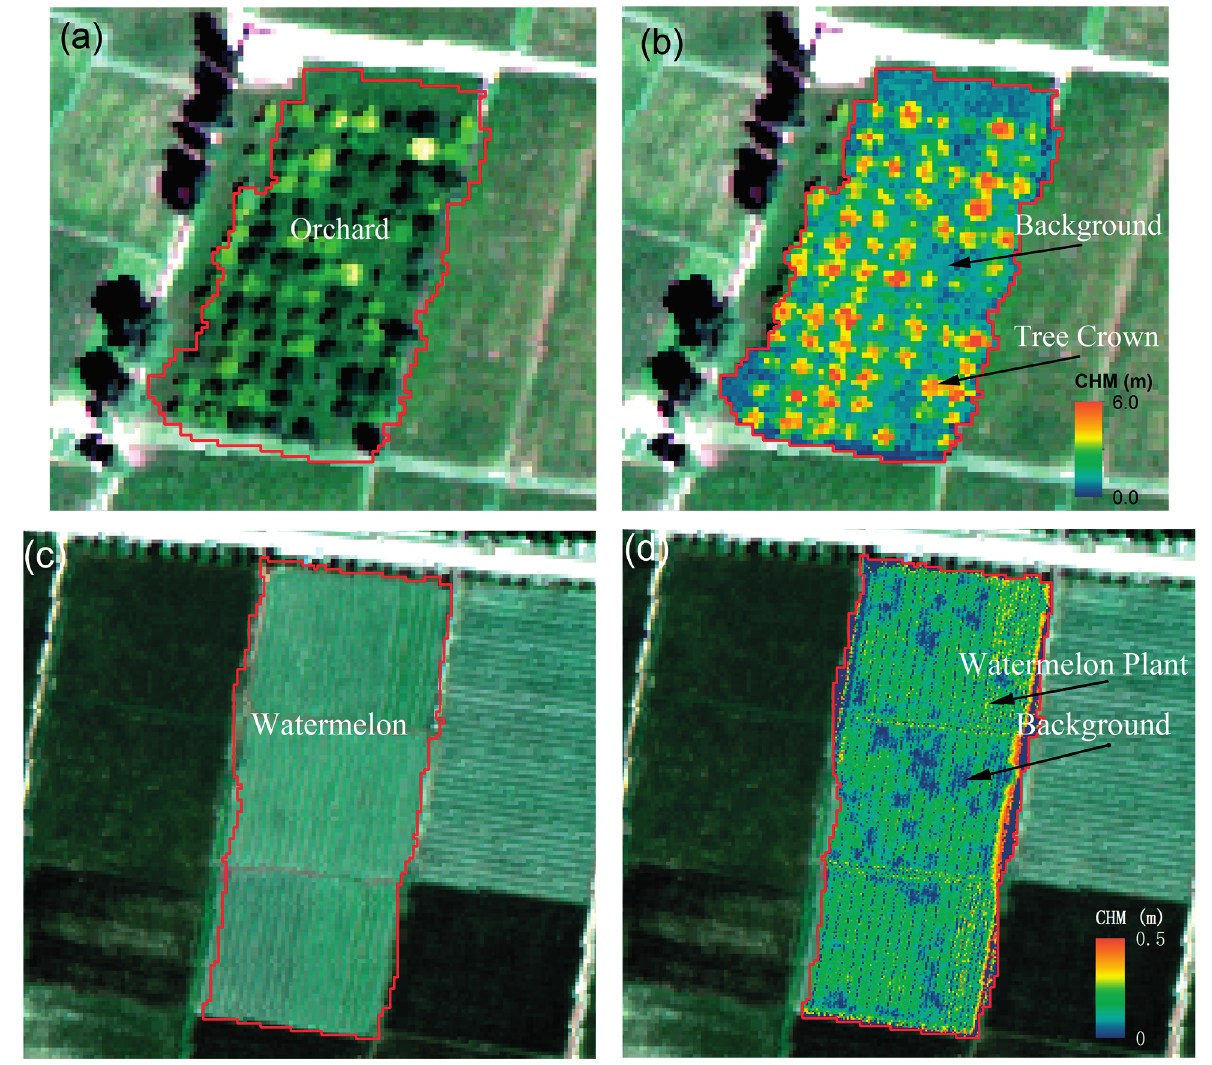
Figure 6. The distribution of the crop CHM value and background in an image object ( a ) Orchard image object, ( b ) CHM distribution in orchard image object; ( c ) Watermelon image object, ( d ) CHM distribution in watermelon image